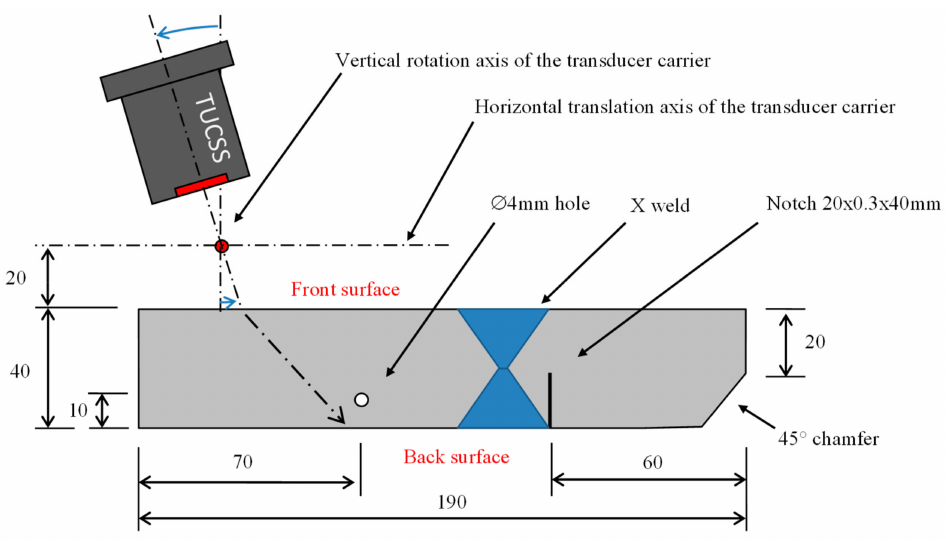
Figure 4. Schematic representation of the test block (horizontal cross